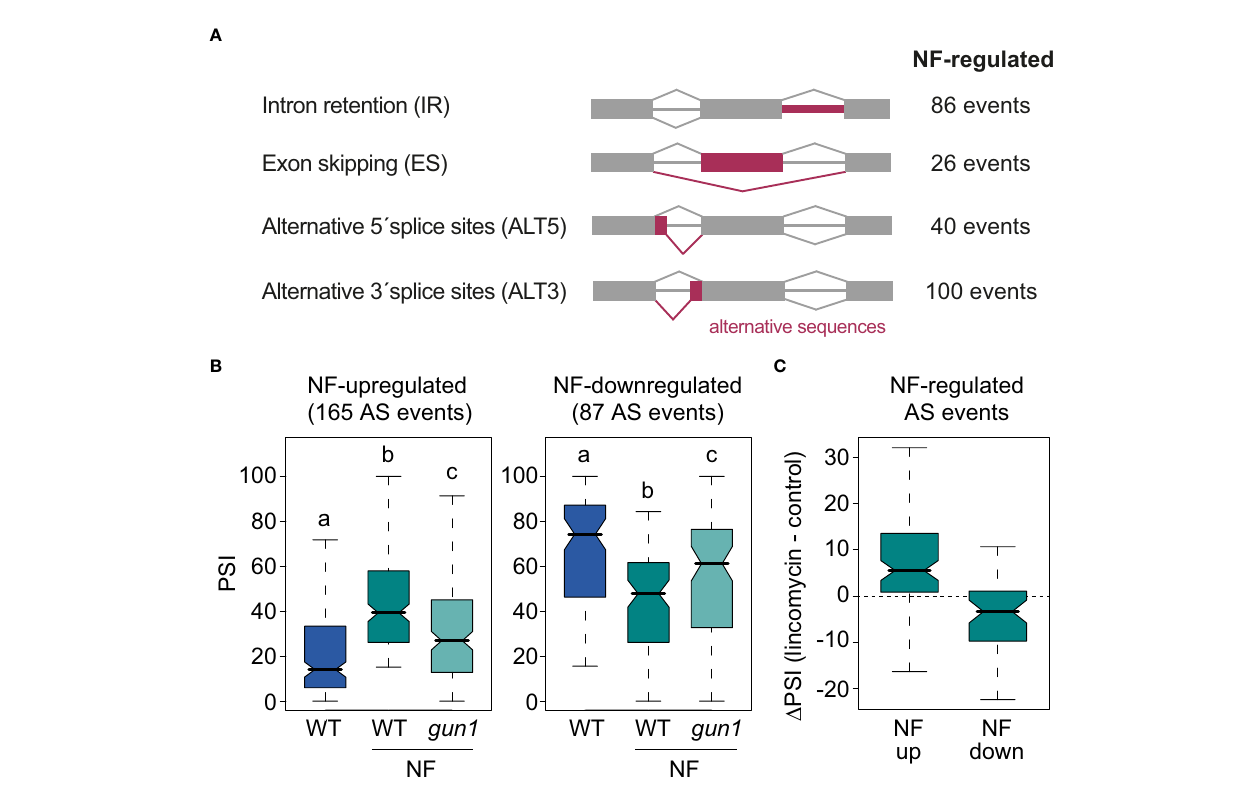
FIGURE 1 AS events regulated by retrograde signals. (A) Schematic representation of the major types of AS events and the number of AS events of each class regulated by nor fl urazon (NF). (B) Percent of inclusion values (PSI) of the alternative sequences of the 165 NF-upregulated (left) and the 87 NF-downregulated (right) AS events in wild-type (WT) and gun1 samples treated or not with NF. Letters denote the statistically signi fi cant differences between medians (Kruskal-Wallis; P < 0.05). (C) Boxplot representation of the D PSI between WT samples treated or not with lincomycin of AS events up- or downregulated by